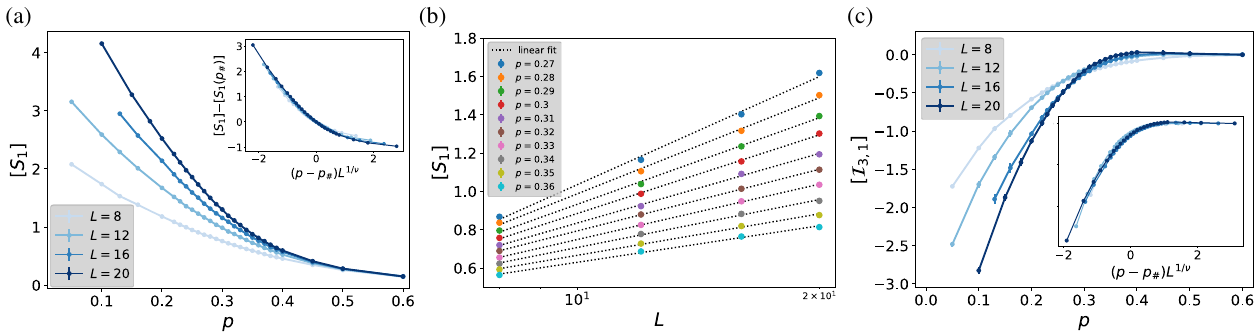
FIG. 7. Entanglement transition in the statistical model qubit contribution. (a) Plot of the qubit entanglement entropy S 1 versus p . The inset shows the finite size collapse using the ansatz discussed in the main text, with ν ∼ 1 . 3 and p # ≈ 0 . 29 . (b) Plot of S 1 versus L near the critical point. We find that at the critical point S 1 grows logarithmically with L . (c) Tripartite mutual information I 3 showing a crossing around p # ≈ 0 . 29 . The inset shows the finite size collapse using the same correlation length exponent as in (a). Error bars on the data points are obtained from the error on the mean by computing the standard